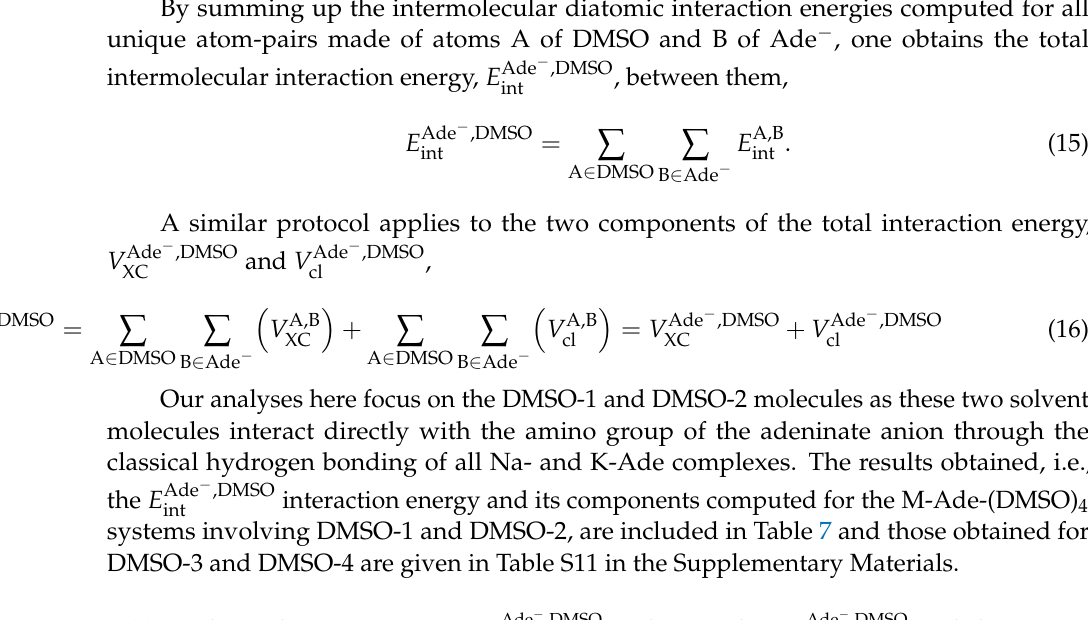
− ,DMSO − ,DMSO , and its covalent, V Ade , and electrostatic, int XC